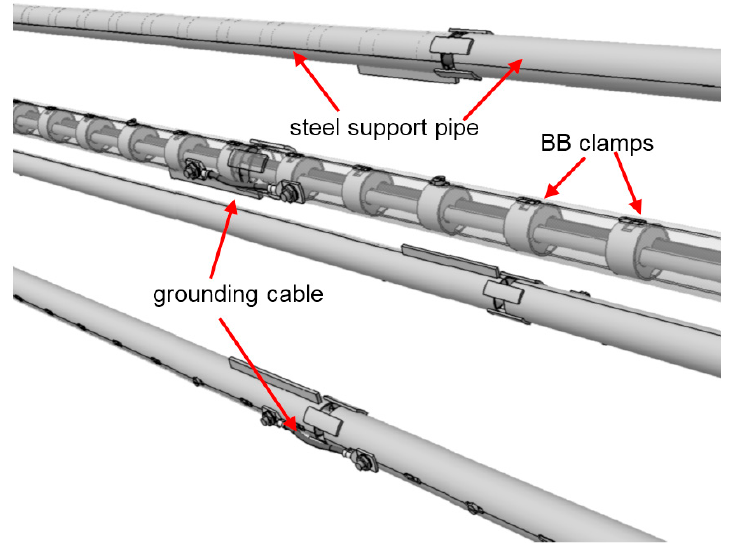
Figure 13. Segments of the busbar (BB) support system.